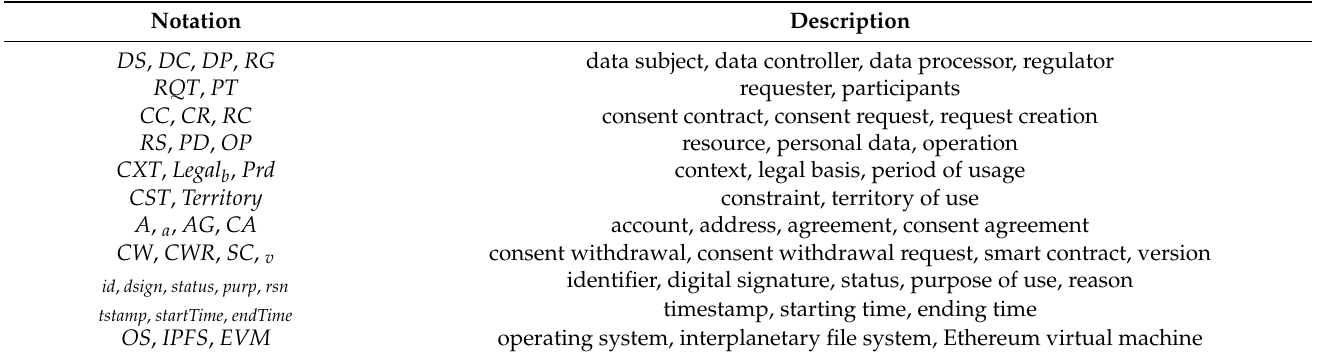
Table 3. Notation